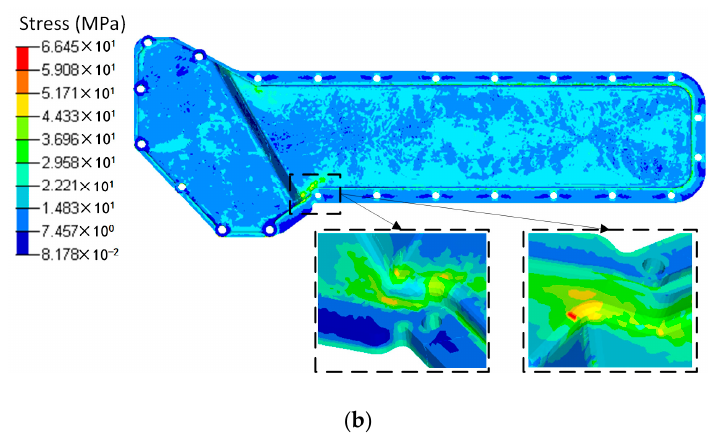
Figure 16 . Stress distributions of ( a ) the isotropic and ( b ) the orthotropic oil cooler covers under distributed temperature difference.